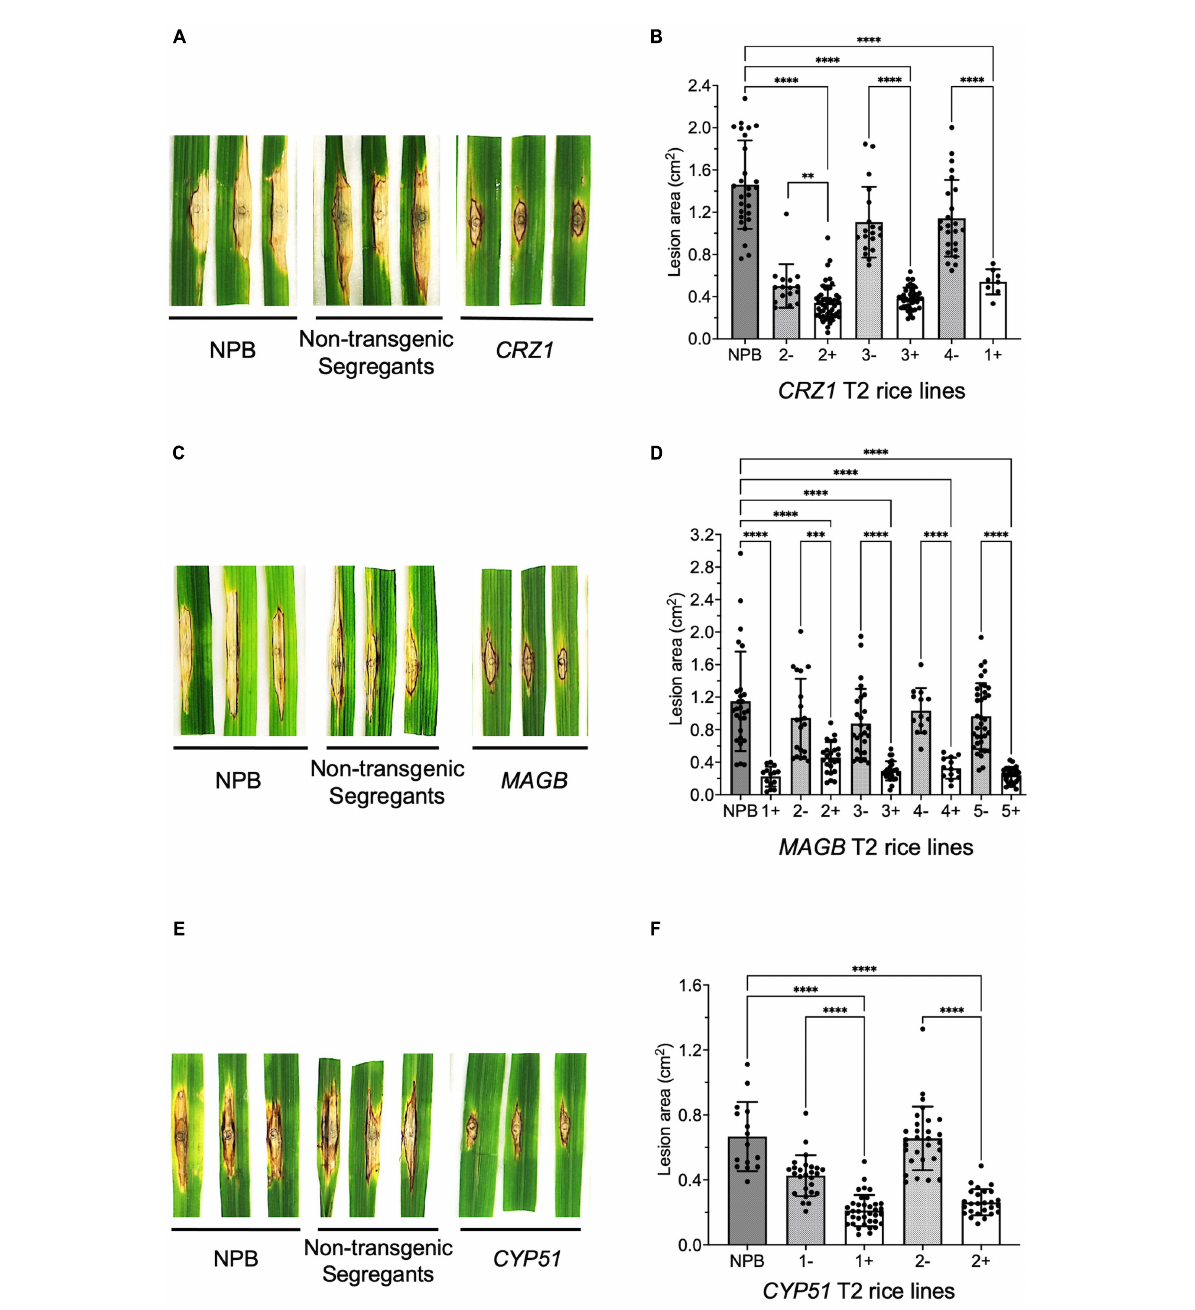
FIGURE6 Confirm resistant host-induced gene silencing (HIGS) transgenic rice in T2 generation. (A–F) Punch inoculation of HIGS transgenic rice plants targeting Magnaporthe oryzae gene CRZ1 (A,B) , MAGB (C,D) , CYP51 (E,F) . Wild type Nipponbare (NPB) and non-transgenic segregants derived from corresponding T1 plants were used as negative control. Lesion area was measured and analyzed statistically (B,D,F) using multiple rice lines. The symbol “ + ” represents positive transgenic plants while “-” represents non-transgenic segregants. Ordinary one-way ANOVA and Turkey’s multiple comparison were used for statistics analysis. ∗∗∗ P < 0.0002, ∗∗∗∗ P < 0.0001.